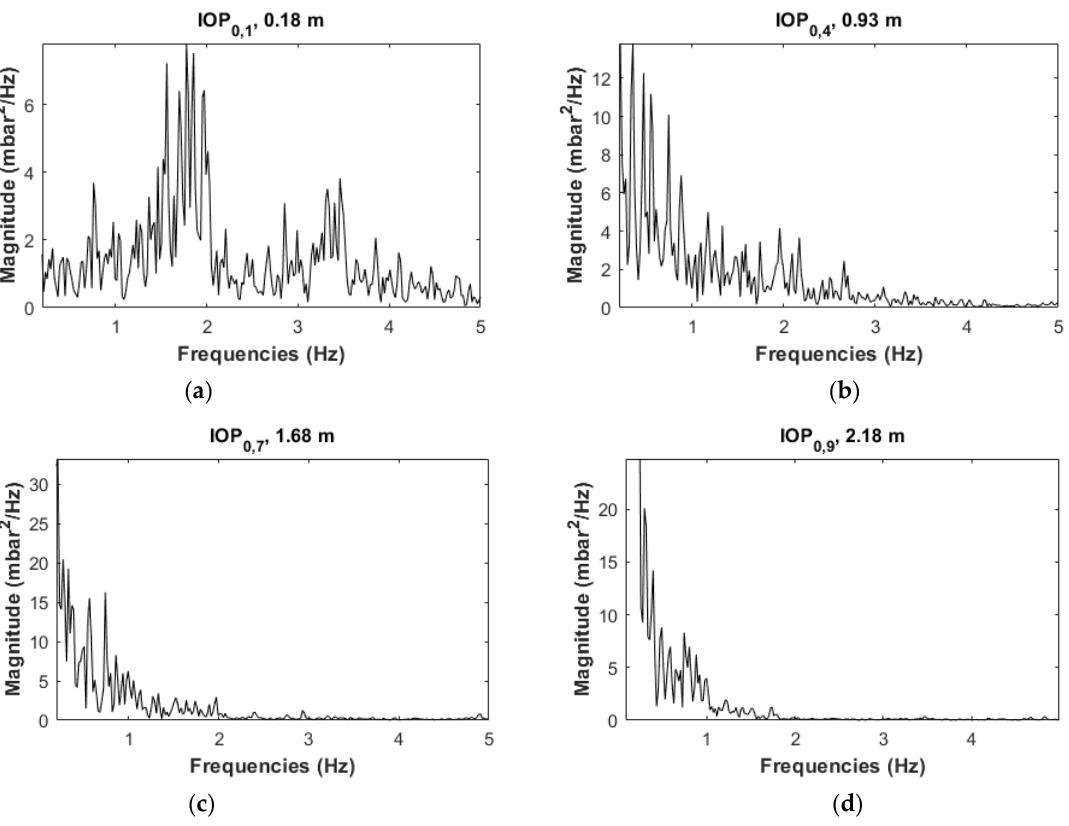
Figure 9. Four spectra obtained at various heights for the same experimental configuration, at U air − U mf = 0.18 m/s and G p = 58 kg/m 2 s: ( a ) 0.18 m, ( b ) 0.93 m, ( c ) 1.68 m and ( d ) 2.18